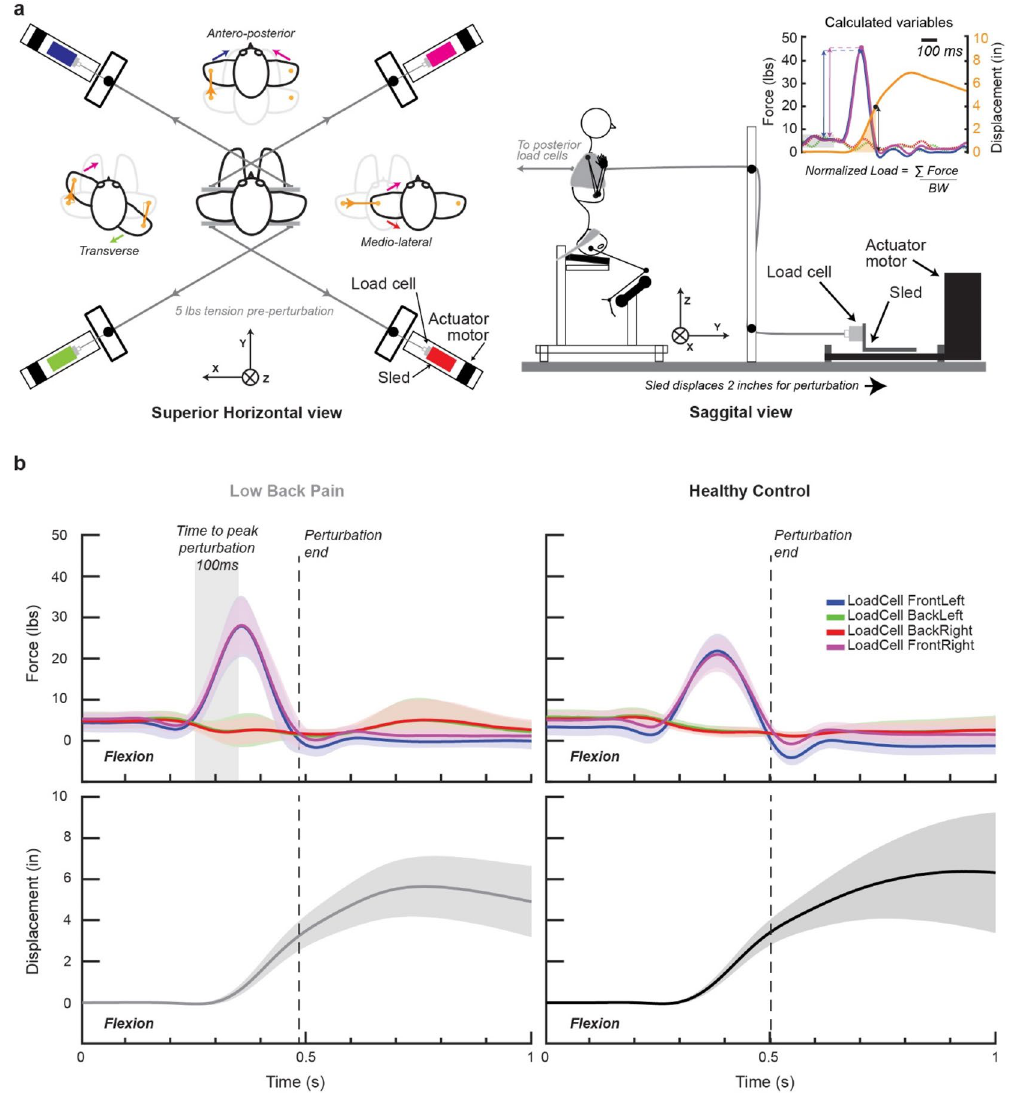
Figure 1. Experimental schematic of perturbation device and average time series data for calculation of Trunk Compliance Index. ( a ) Schematic of perturbation puller system with examples of motor combinations to produce directional perturbations and example calculation of measures, displacement and perturbation load. BW, Body weight. ( b ) Average time series profile of perturbation load (top panels) and displacement (bottom panels) for an individual with chronic low back pain (left panels) and matched control (right panel). Perturbations reached peak loads within 100 ms and displacement was calculated at the zero crossing following peak